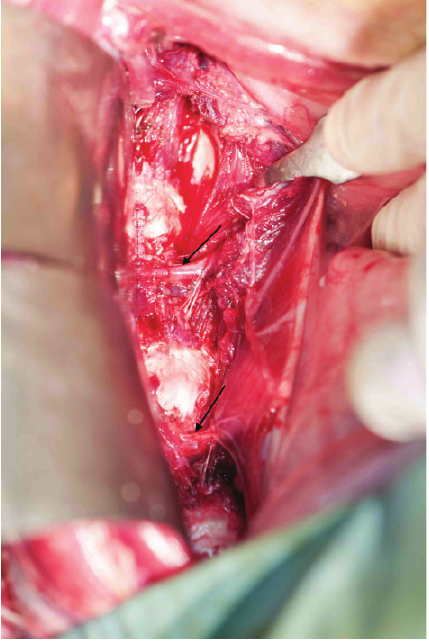
Figure 2: Intraoperative photo demonstrating radicular vessels at two levels (arrows) running horizontally across vertebral bodies 1cm below intervertebral